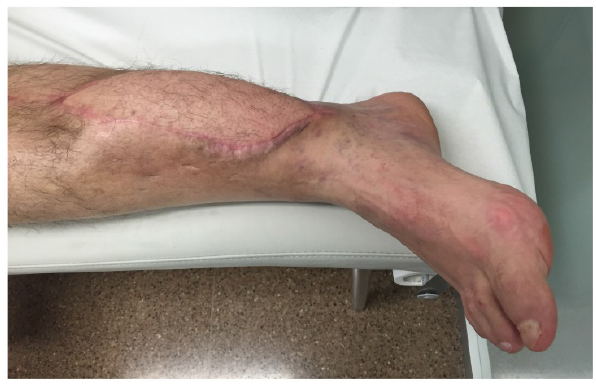
Figure 7. Last follow-up, lateral thigh free muscle flap has survived completely with absence of recurrence of